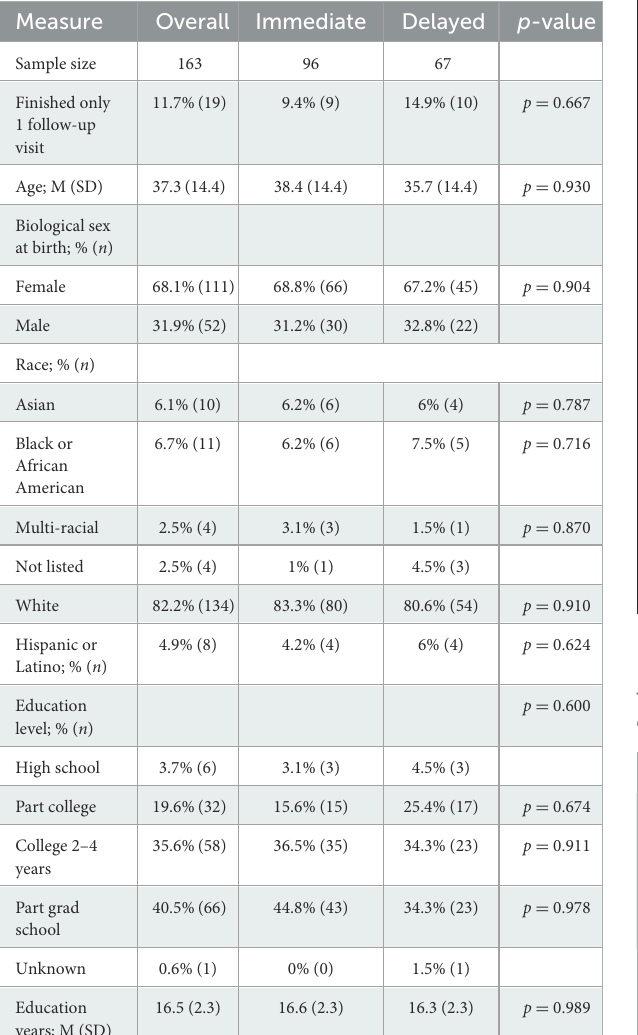
TABLE 1 Participant characteristics at baseline.